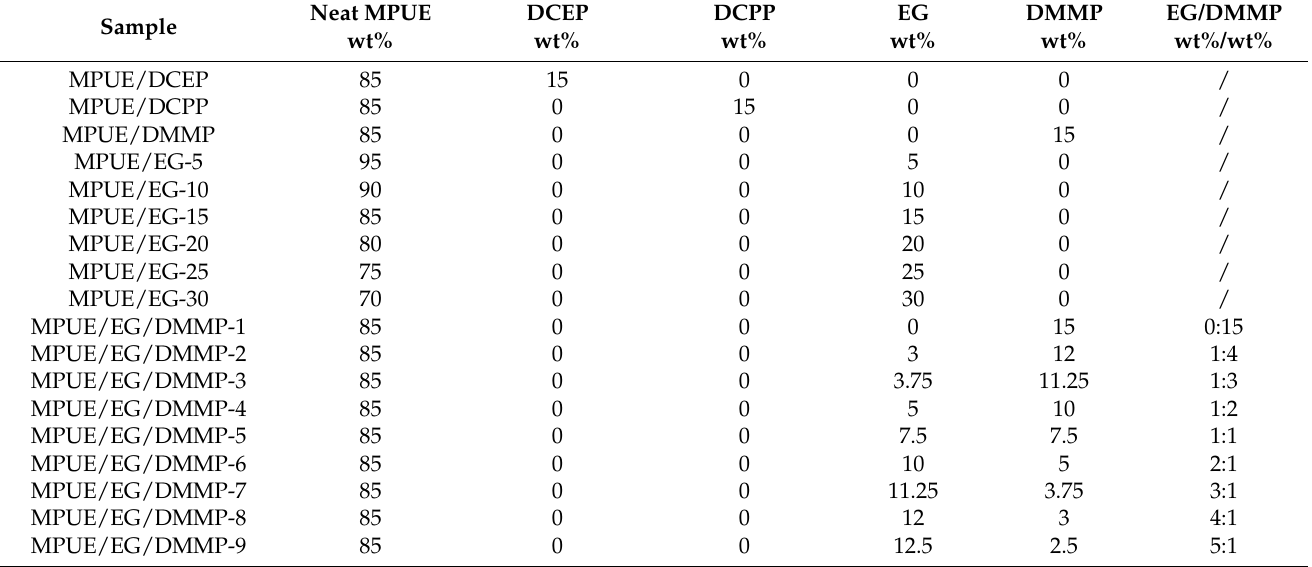
Table 3. FR/MPUE composites studied in this work and their synthetic